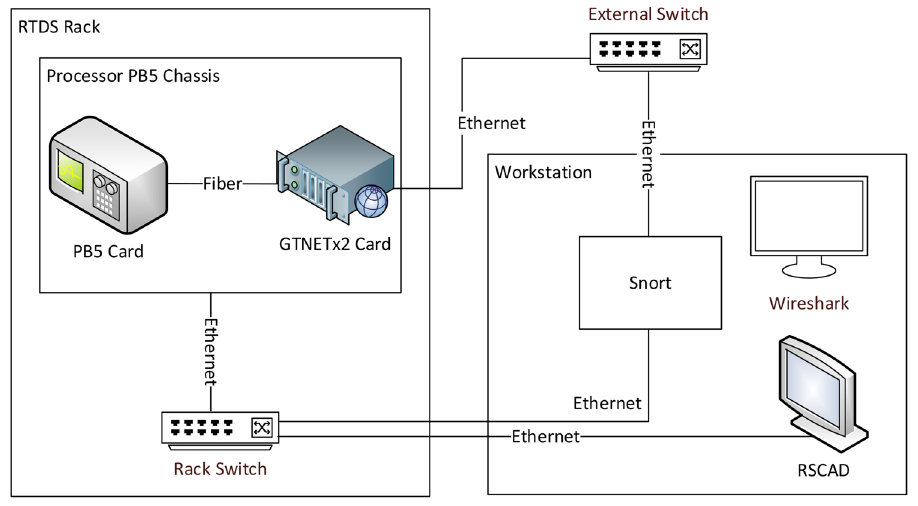
Figure 2. Testbed with RTDS, Snort, and Wireshark 6